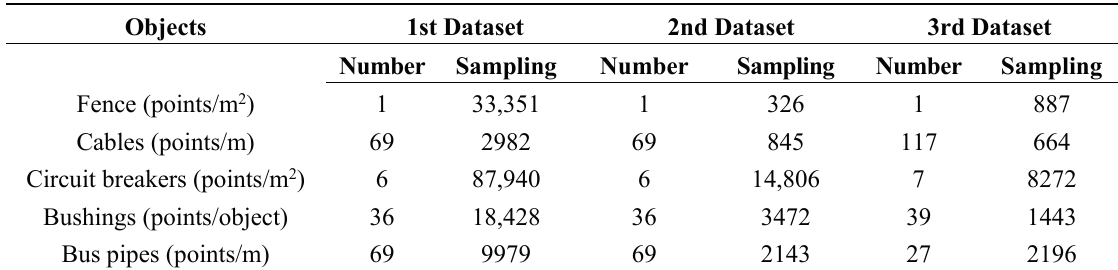
Table 3. The number and average point sampling of each type of object in three